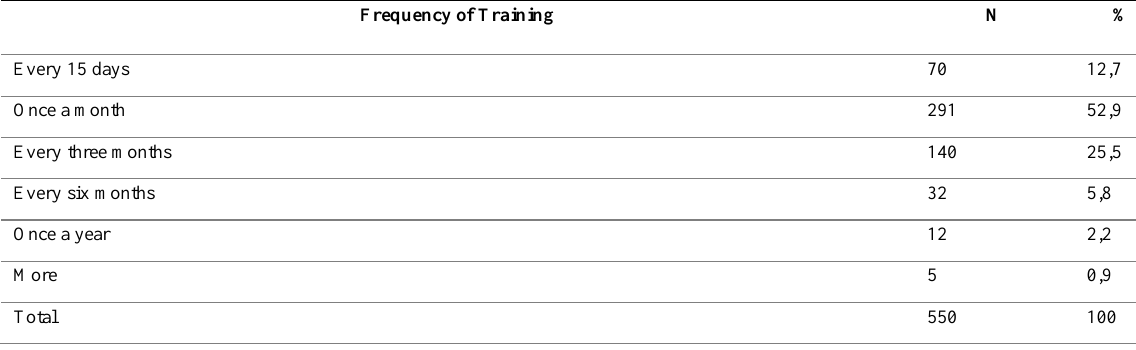
Table 16: Frequency of Organizing In-Service Trainings